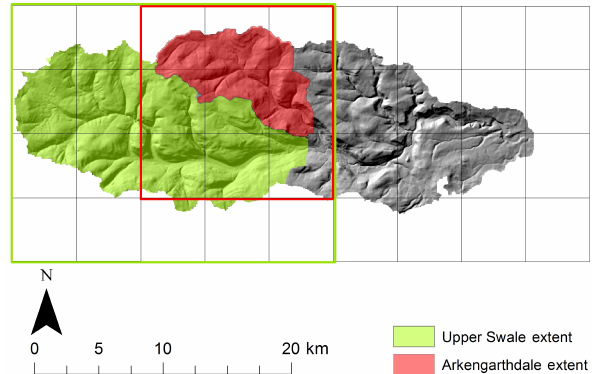
Figure 1. Map showing the extents of the three test basins with the Upper Swale in green and the Arkengarthdale extent in red. Addi- tionally, the 5km rain radar grid cells overlaying the three basins are shown – coloured according to the basins they